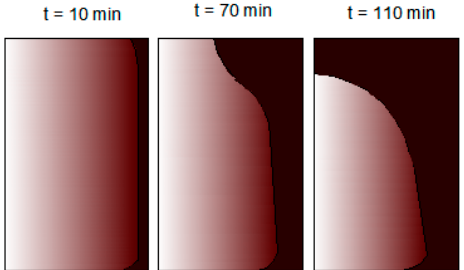
Figure 3. Melting process in a rectangular cavity with heat transfer on one side, adapted from work [61]: the dark region corresponds to liquid and the light region to solid.